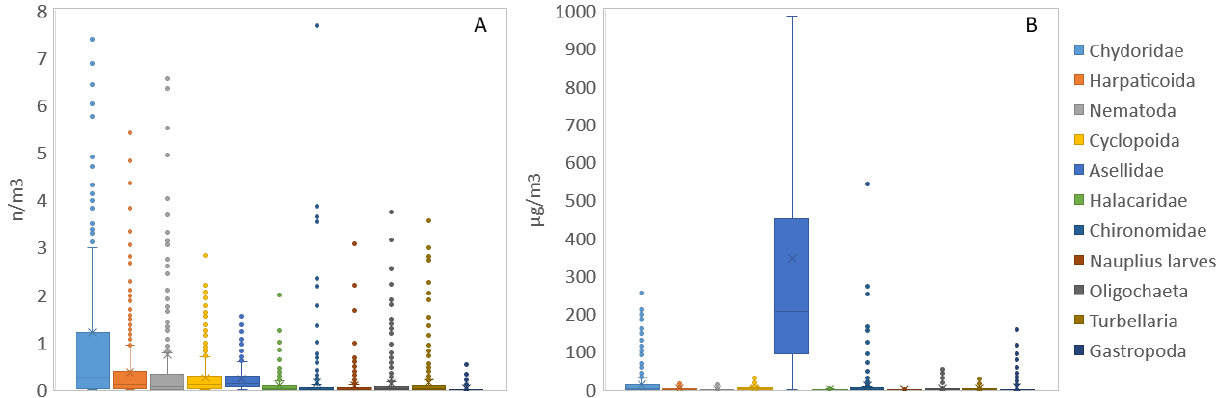
Figure 5. ( A ) abundance and ( B ) biomass of invertebrates collected in sediment of the study system at location E1 over the period January 2011 to December 2021. Invertebrates were collected in filters in place for one to two weeks (Table 1), and the biomass was normalized to a cubic meter of filtered water. Box plots represent the median, lower and upper quartiles of data collected over the entire study period.